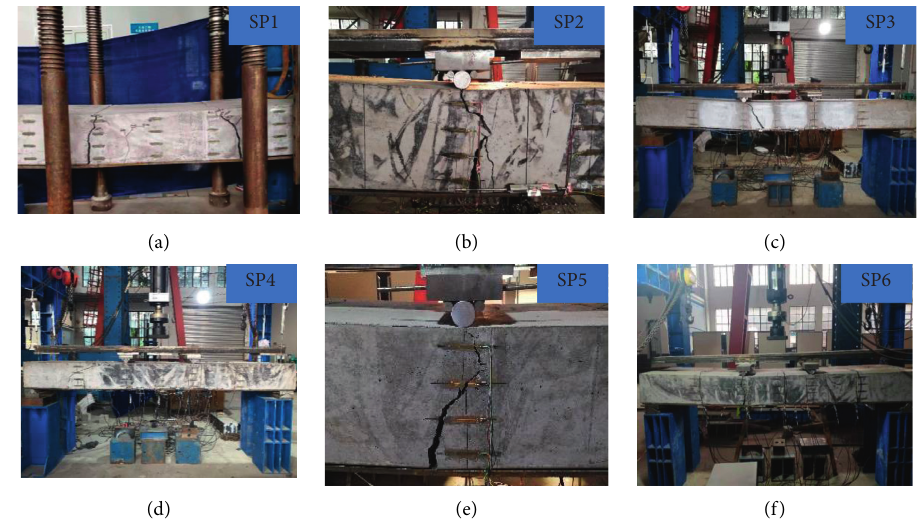
Figure 7: Brittle failure of specimens.